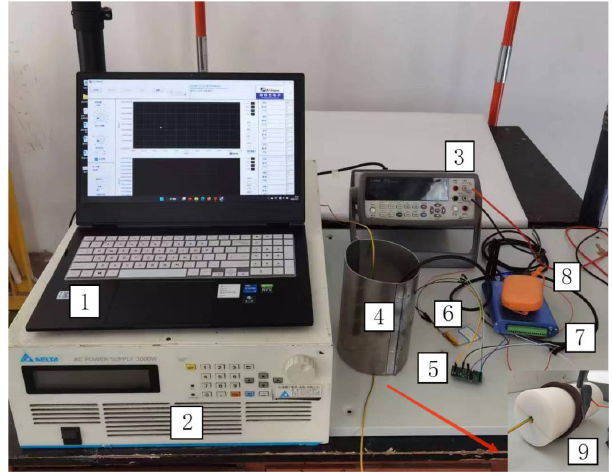
Figure 12. Experimental test site: (1) PC; (2) 220 V voltage source; (3) digital multimeter; (4) shield; (5) circuit module; (6) op-amp power supply battery; ( 7 ) data acquisition instrument; (8) data acquisition instrument power supply battery; and (9) probe.